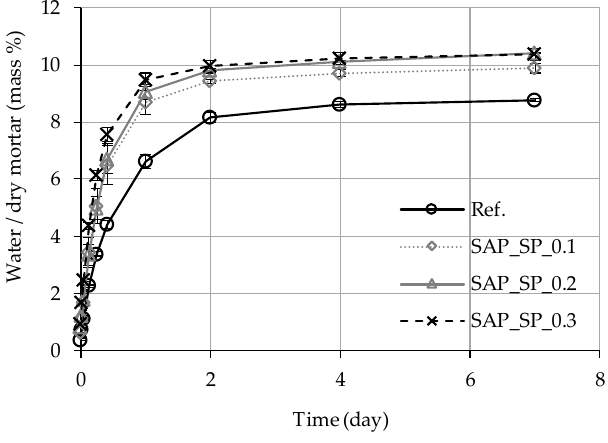
Figure 5. Capillary water absorption of mortar samples according to time immersed in water.